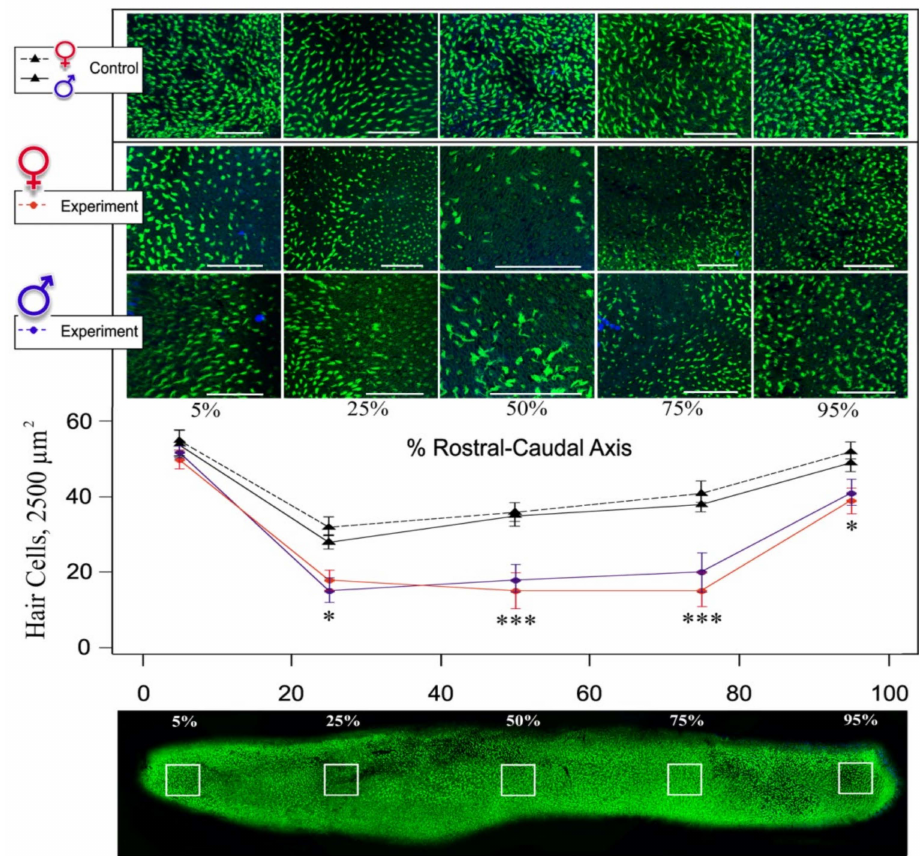
Figure 3. Effect of noise exposure on phalloidin-labeled auditory epithelium of stone sculpin males and females. The bottom image shows the five areas of hair cell counts along the rostral-caudal axis of the saccule from the most rostral (5%) to the most caudal (95%). Data are presented as mean ± standard error. Statistically significant differences are observed within 25–95% rostral- caudal areas between control and experimental samples, both male and female, and indicated with asterisks: * p < 0.05, *** p < 0.001 (2-Way ANOVA, Tukey HSD